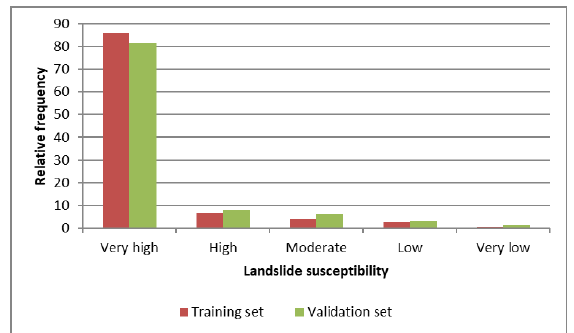
Figure 5. Histograms showing distribution of training (red) and validation (green) data in landslide susceptibility classes The landslide susceptibility model indicates that 10% (100%- 90% classes) and 20% (100%-80% classes) of the most susceptible in the area contain an average of 76% and 86%, respectively, of the training data (Figure 6). The model can thus be regarded as a good fit to the training data. Moreover, the model indicates that 10% and 20% of the most susceptible areas contain 73% and 82%, respectively, of the validation data set.